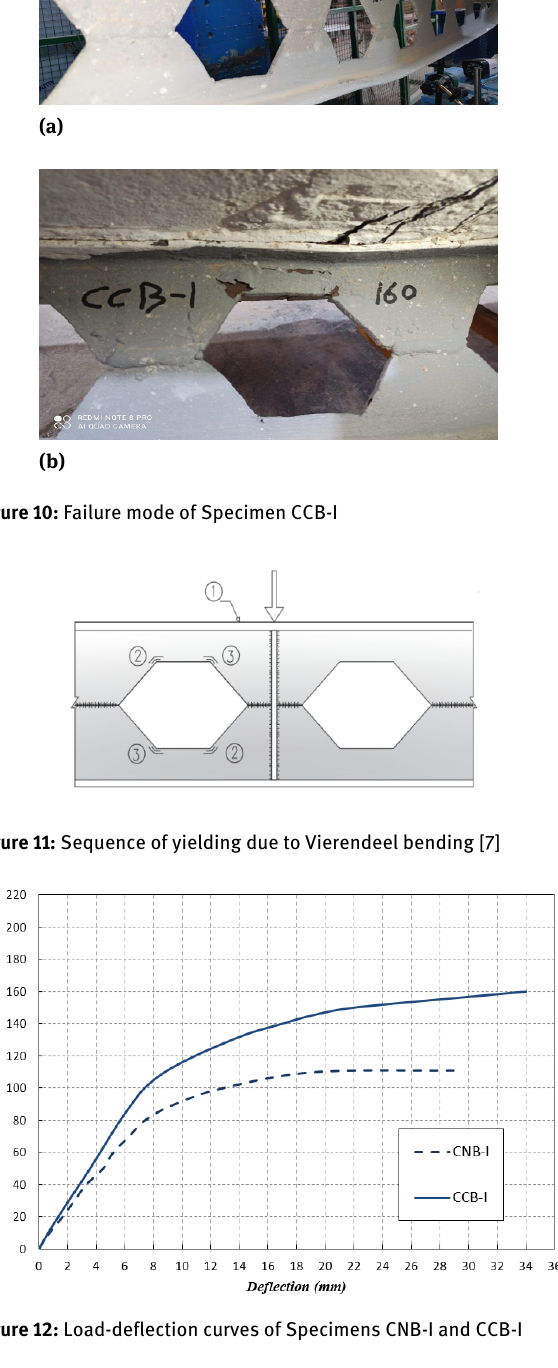
load-deflection curves of CNB-I and CCB-I specimens are shown in Figure 12. In the case of Specimen CCB-I, flexural stiffness has improved significantly because the castellated beam is deeper than the parent section.